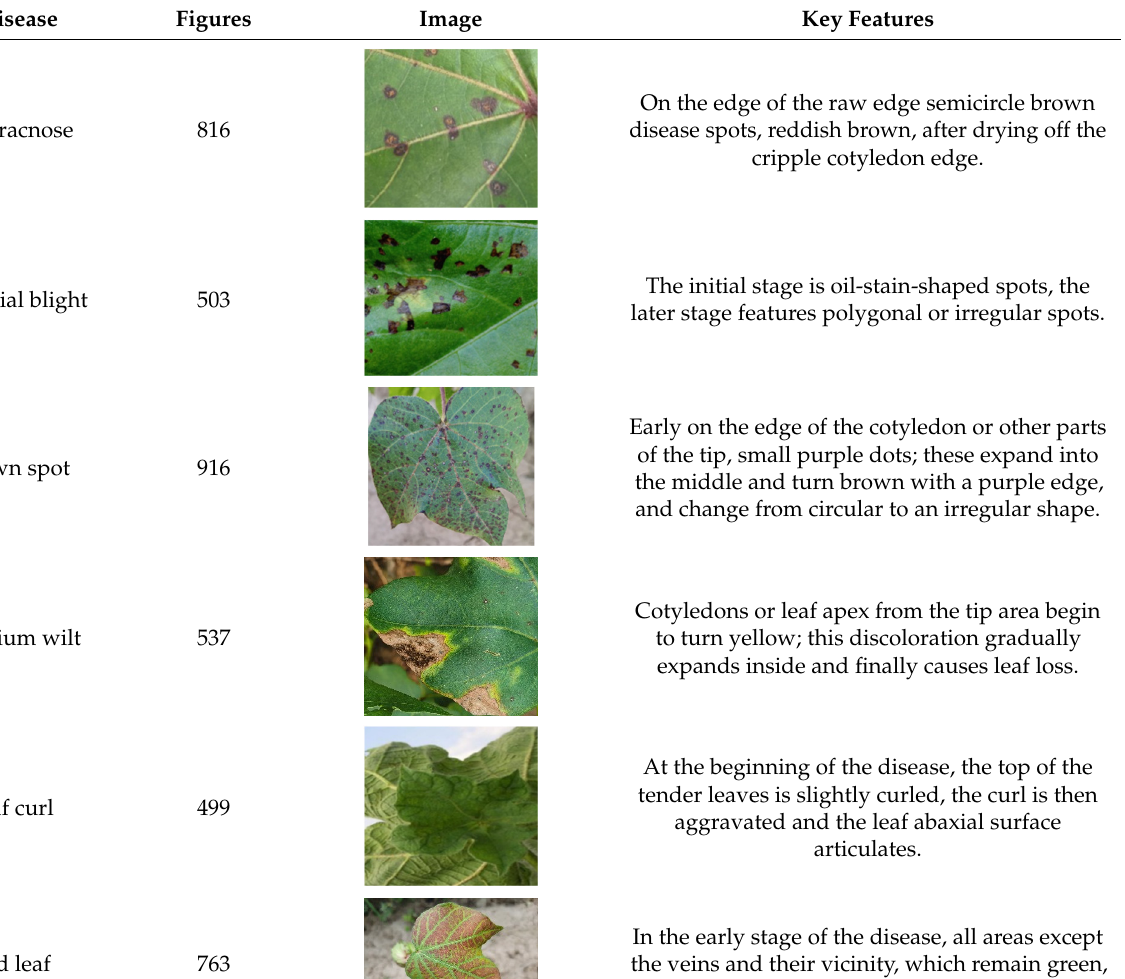
Table 1. The types, figures, image samples, and key features of each leaf disease in the dataset.